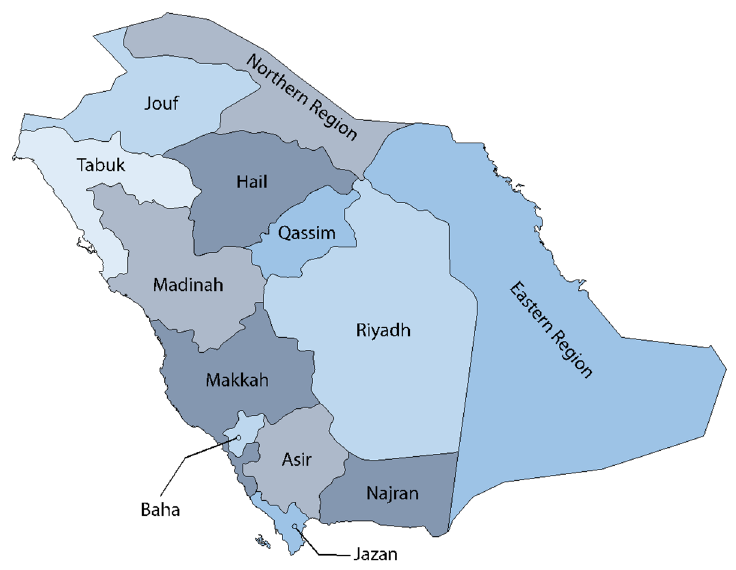
Figure 1. Administrative regions of Saudi Arabia. All of the 13 administrative regions are labeled in their location within the map (map modified from Vemaps.com).